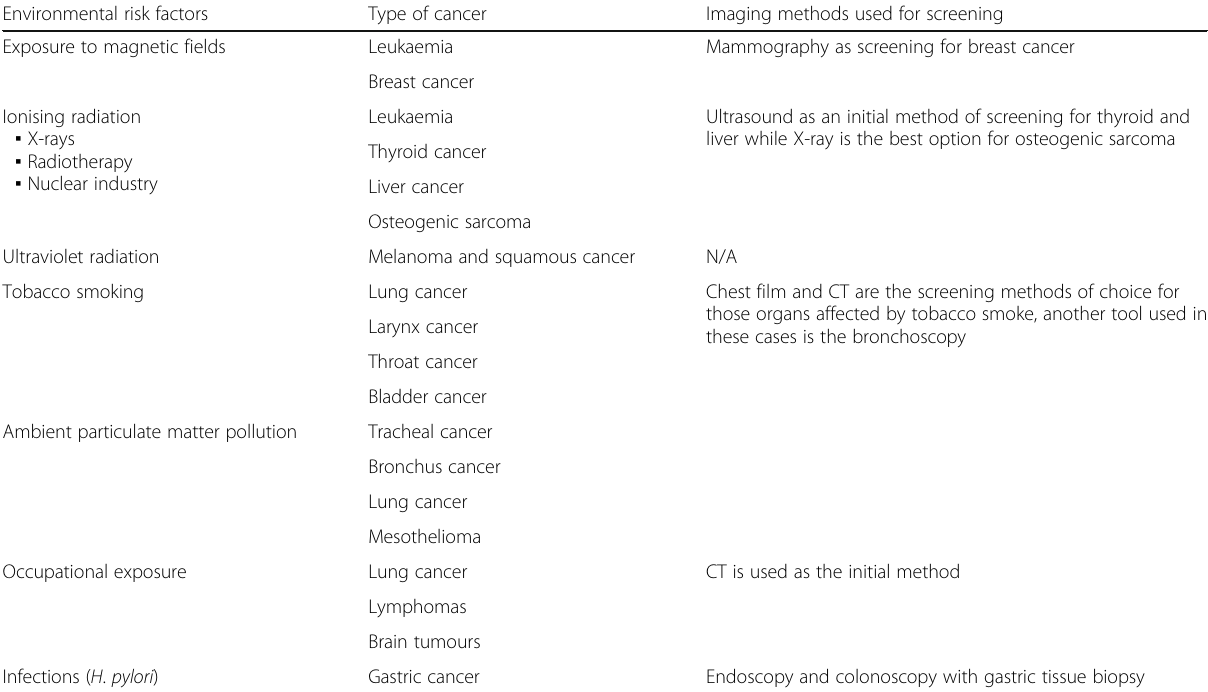
Table 3 Use of imaging methods in the screening of patients with cancer risk for exposure to environmental factors Environmental risk